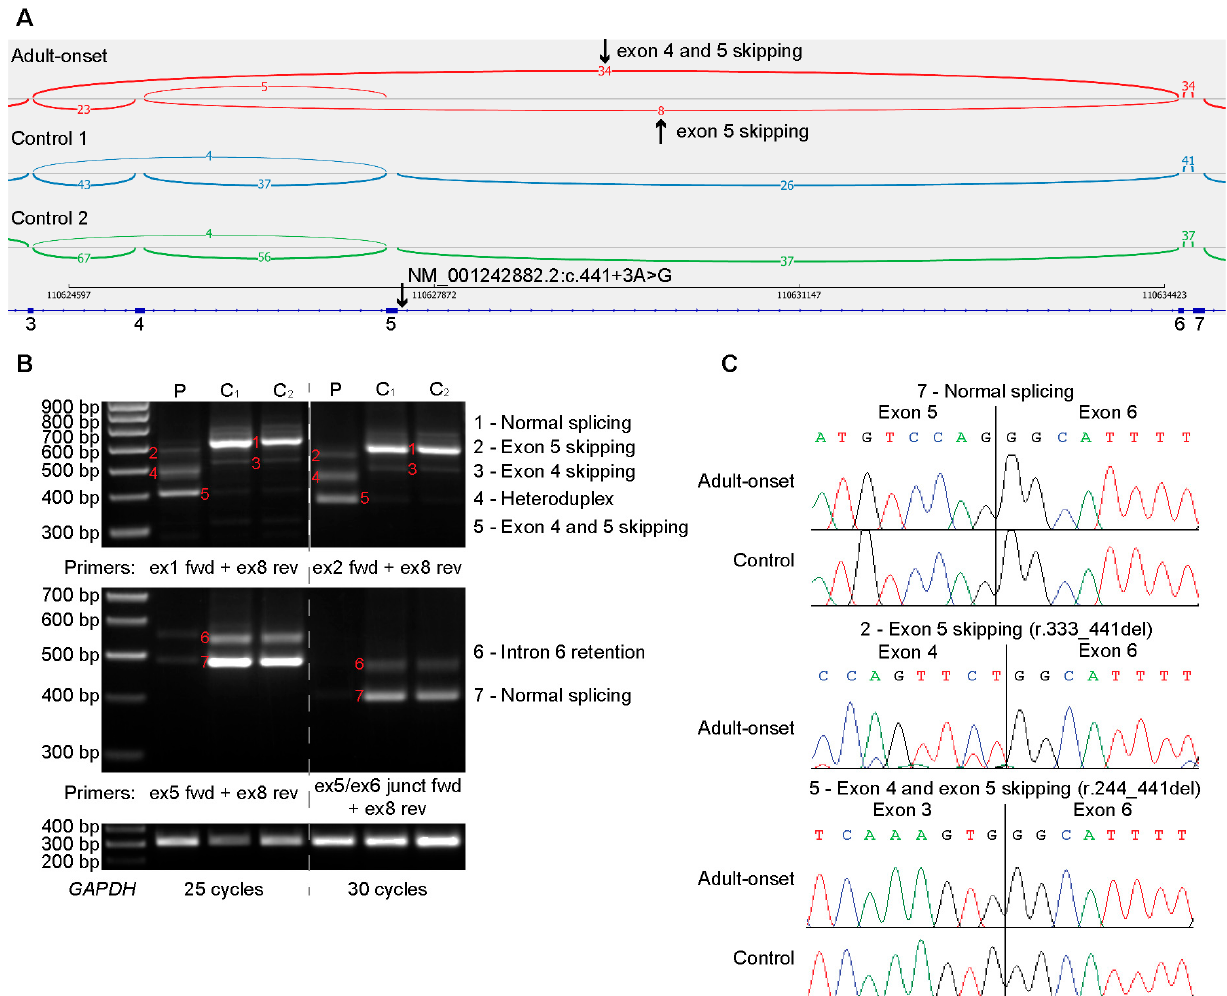
Figure 2. Transcriptomic and RNA splicing analyses of the NAXD c.441+3A>G variant. ( A ) Sashimi plots of RNA-Sequencing showing splicing of NAXD exons 3–7 in blood RNA from the adult patient (red) and two controls (blue, green). Exon 5 and exon 4–5 skipping is only detected in the adult sample and absent from controls. No annotated exon 5–6 splicing is detected in the adult sample. Minimum splice junction count = 3; control 1 = male, 34 years; control 2 = male, 8 years. ( B ) Confirmatory RT-PCR detects exon 4 and exon 4–5 skipping in the adult sample using a forward (fwd) primer in exon 1 or exon 2 and a reverse (rev) primer in exon 8 (ex1 fwd + ex8 rev; ex2 fwd + ex8 rev). Trace levels of canonical exon 5–6 splicing are detected in the adult samples using a forward primer in exon 5 or to the exon 5–exon 6 splice junction and a reverse primer in exon 8 (ex5 fwd + ex8 rev; ex5/ex6 junction fwd + ex8 rev). Amplification of GAPDH demonstrates cDNA loading. Lanes: Adult patient (P), Control 1 (C1) (male, 35 years), Control 2 (C2) (male, 36 years). ( C ) Sanger sequencing chromatograms of gel-excised RT-PCR amplicons showing exon 4 and exon 4–5